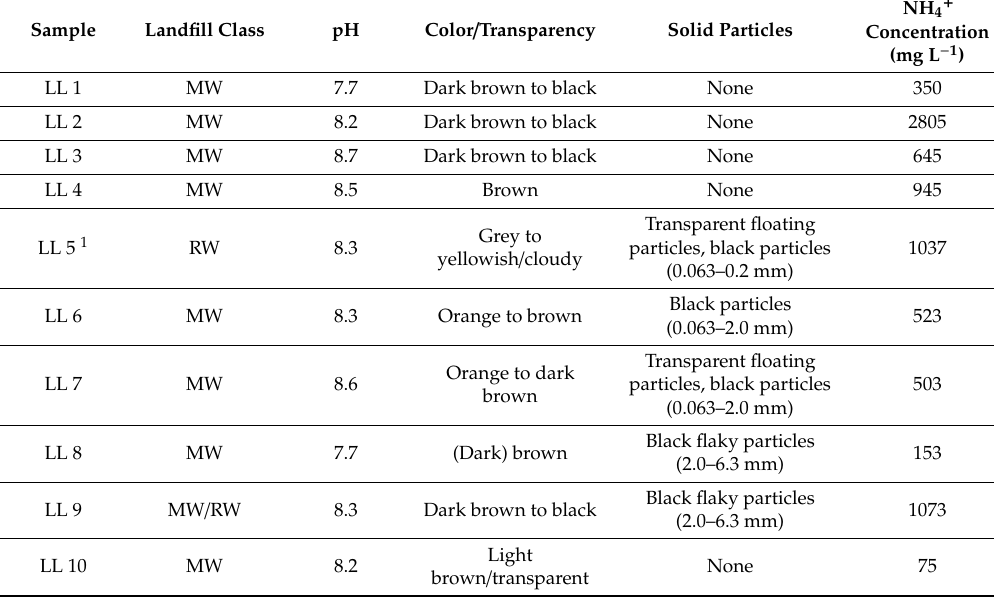
Table 1. Landfill leachates (LL) used for NH 4 + ion exchange experiments, their corresponding landfill class, pH value, color / transparency, presence of solid particles and initial NH 4 + concentrations. MW: mass waste landfill, RW: residual waste